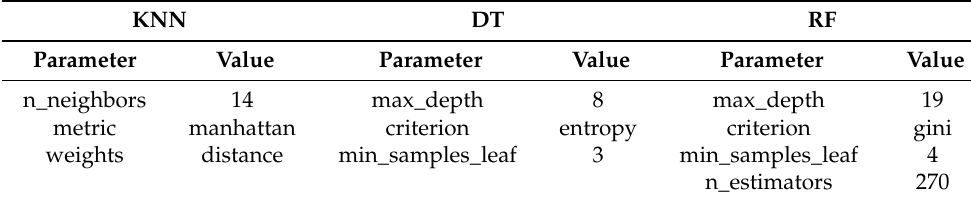
Table 2. Obtained values for hyper-parameters—Part II. SVM SLP MLP LSTM Par. Val. Par. Val. Par. Val. Par. Val. kernel rbf loss perceptron hidden_size